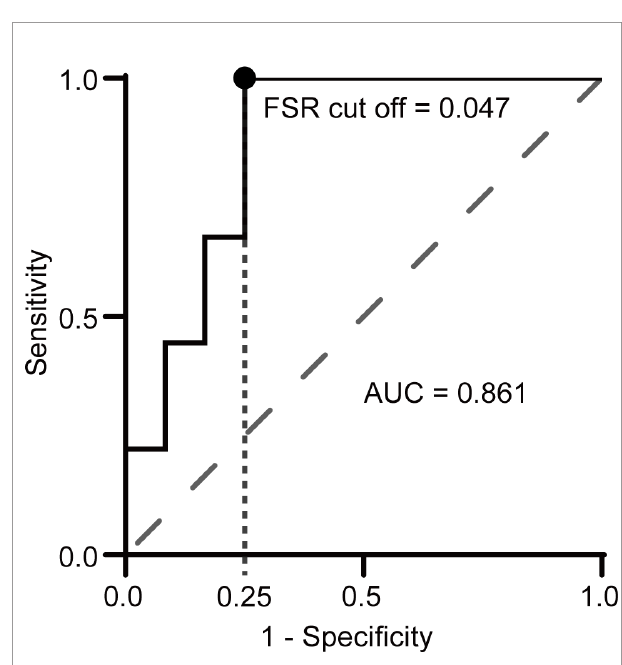
FIGURE 4 | Receiver operating characteristic (ROC) curve analysis of FSR for discriminating NMDARE from other AEs. A circle indicates the point closest to the upper left corner. The AUC was 0.86 (95% CI 0.70 – 1.00), and the FSR cutoff value of 0.047 yielded a sensitivity of 1.00 and a speci fi city of 0.75.